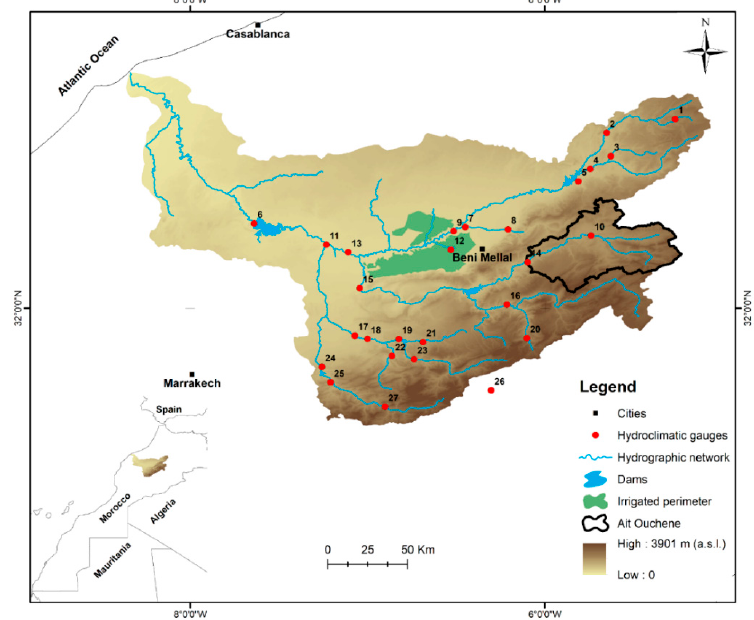
Figure 1. The geographical setting of the study area. The brown area refers to the digital elevation model of the Oum Er-Rbia river basin (OERB).